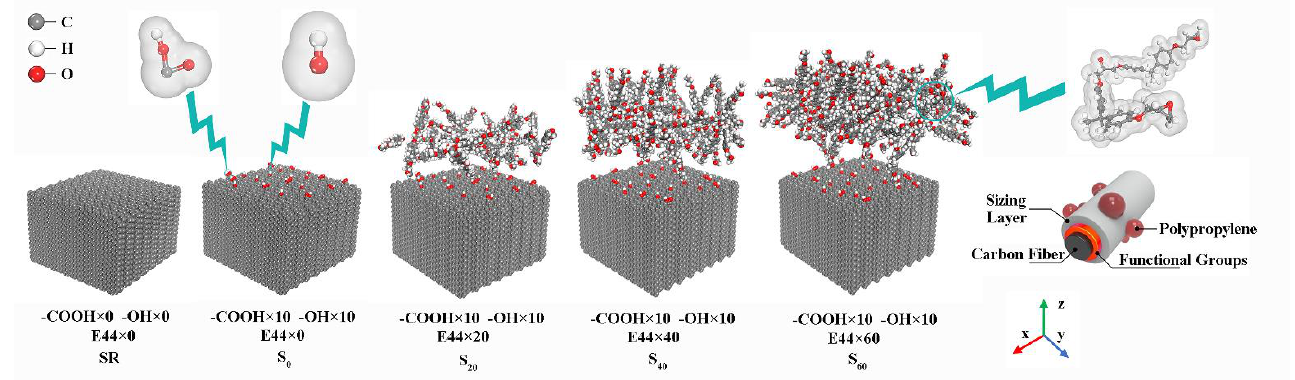
Figure 7. Carbon fiber models with different numbers of E44.